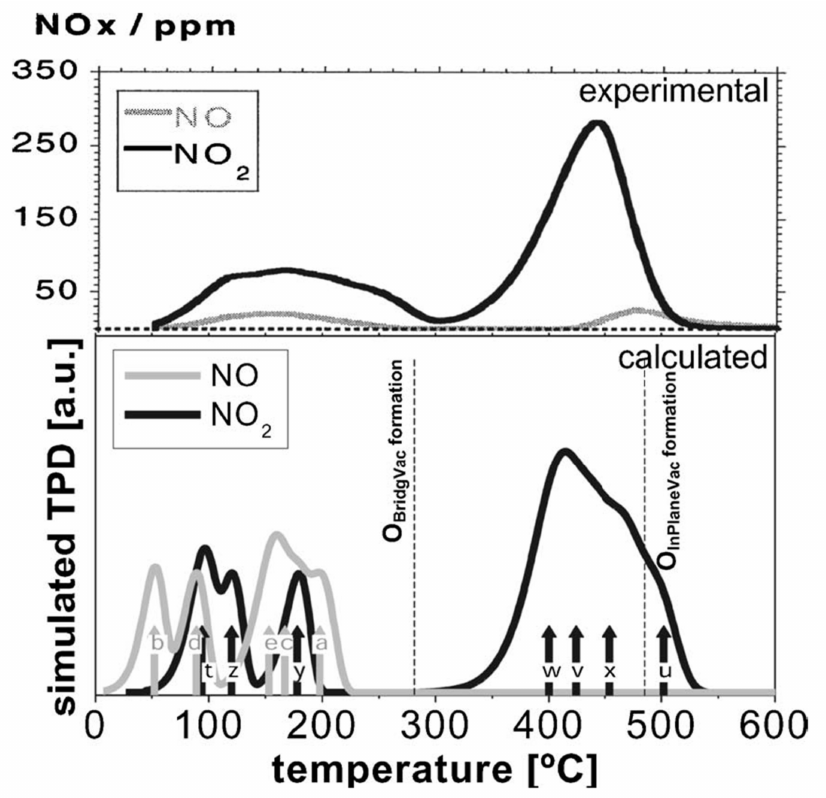
Figure 13. Comparison of empirical and simulated NOx desorption in TPD of SnO 2 after exposure to NO 2 . Reproduced with permission from Reference